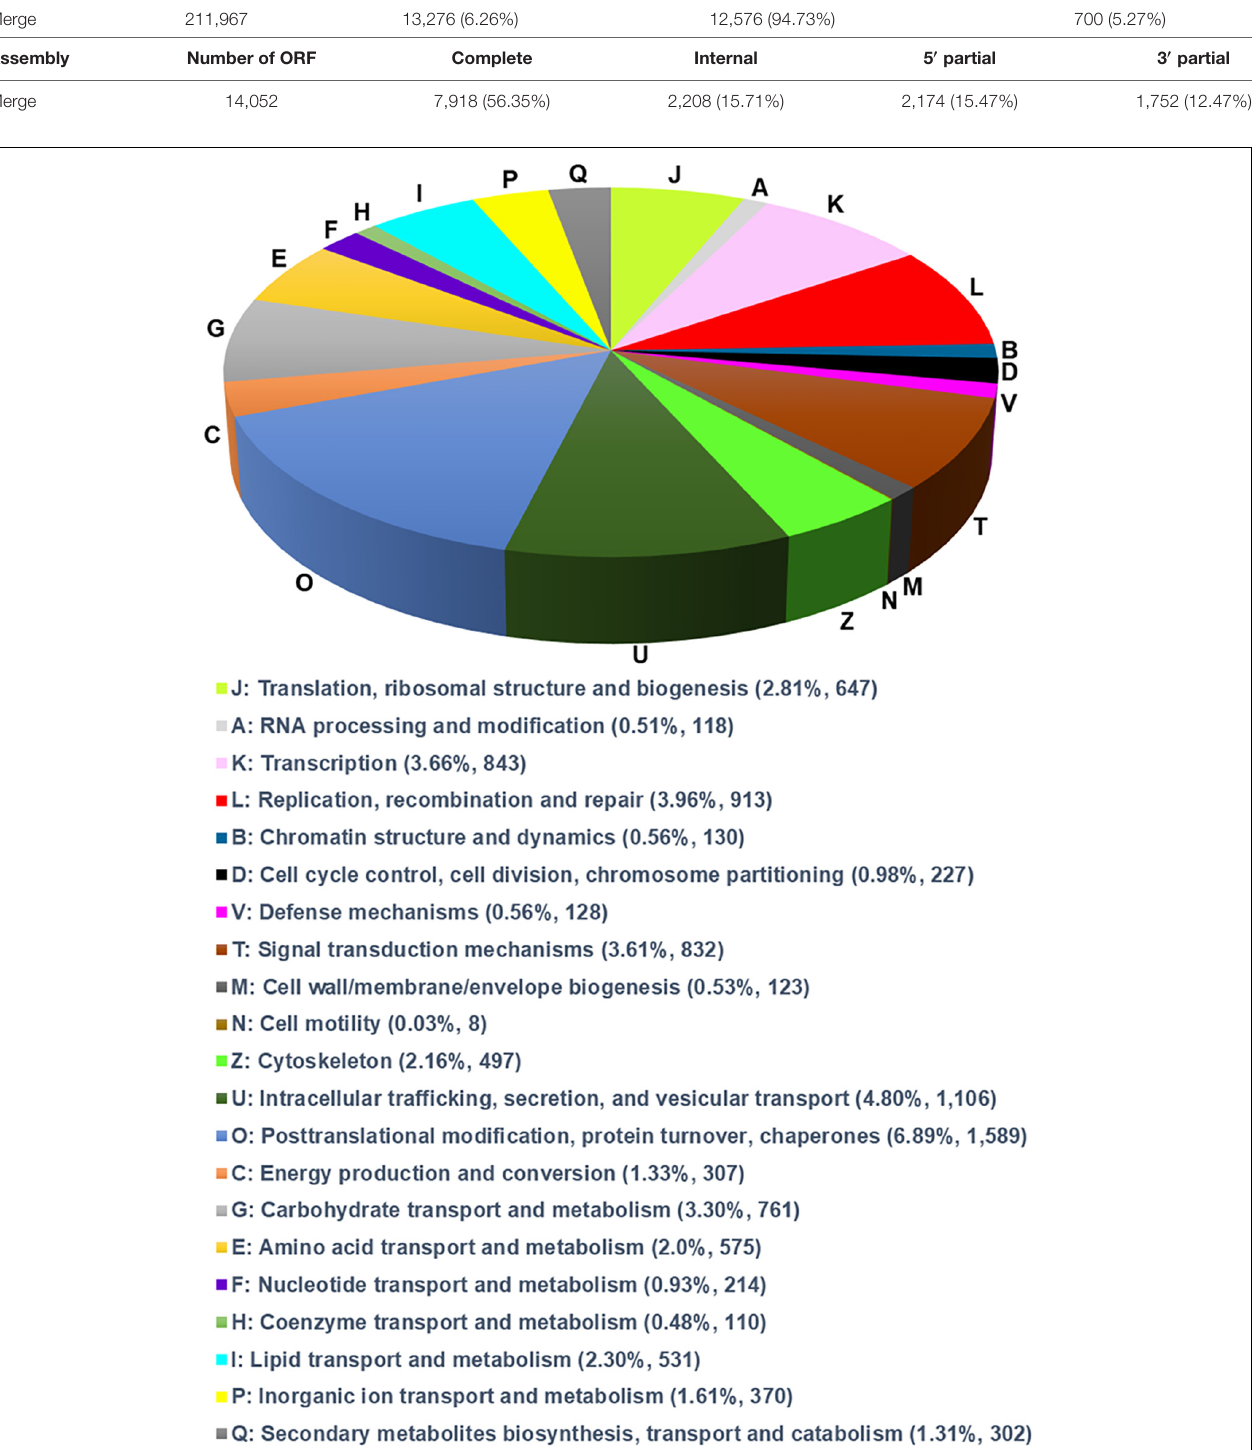
Frontiers in Physiology |